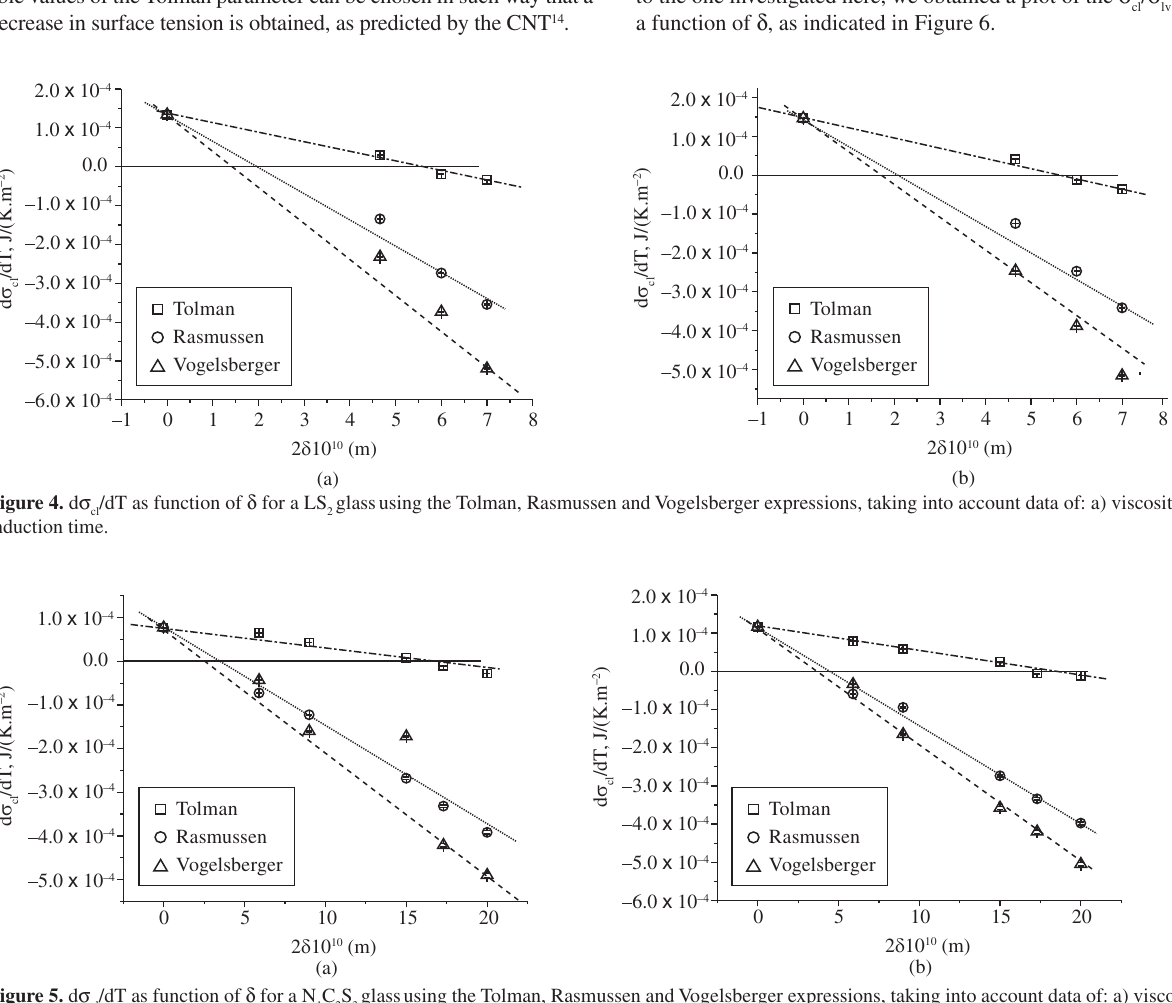
C S glass using the Tolman, Rasmussen and Vogelsberger expressions, taking into account data of: a) viscosity, and 1 2 3